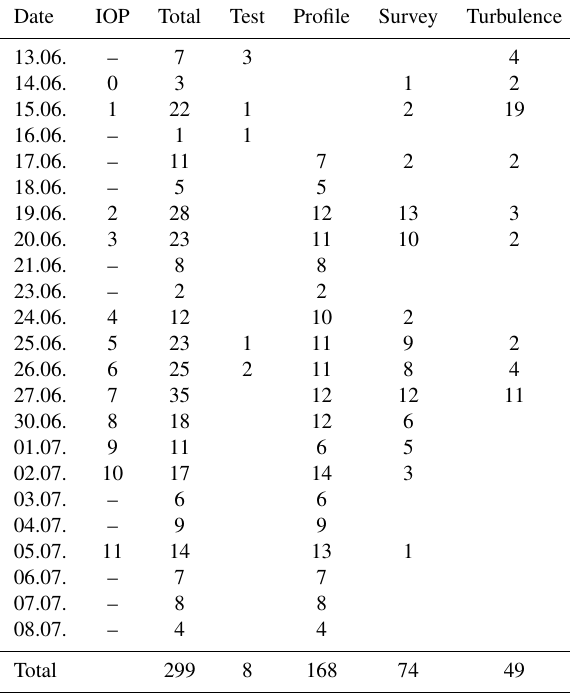
Table 2. SUMO operations during the BLLAST campaign. Profile Survey